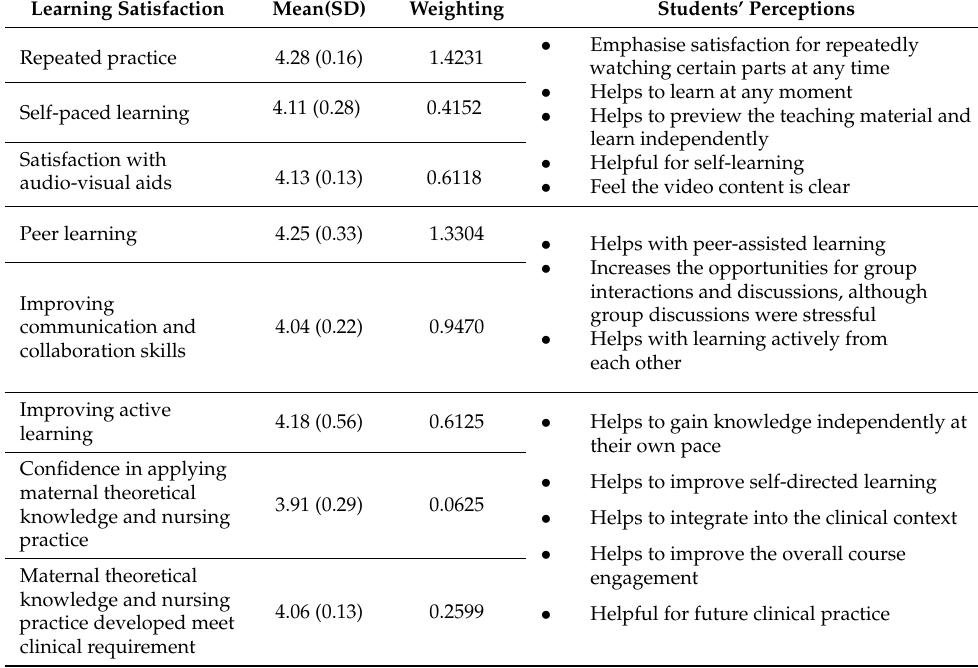
Table 2. Joint Display of Students’ Learning